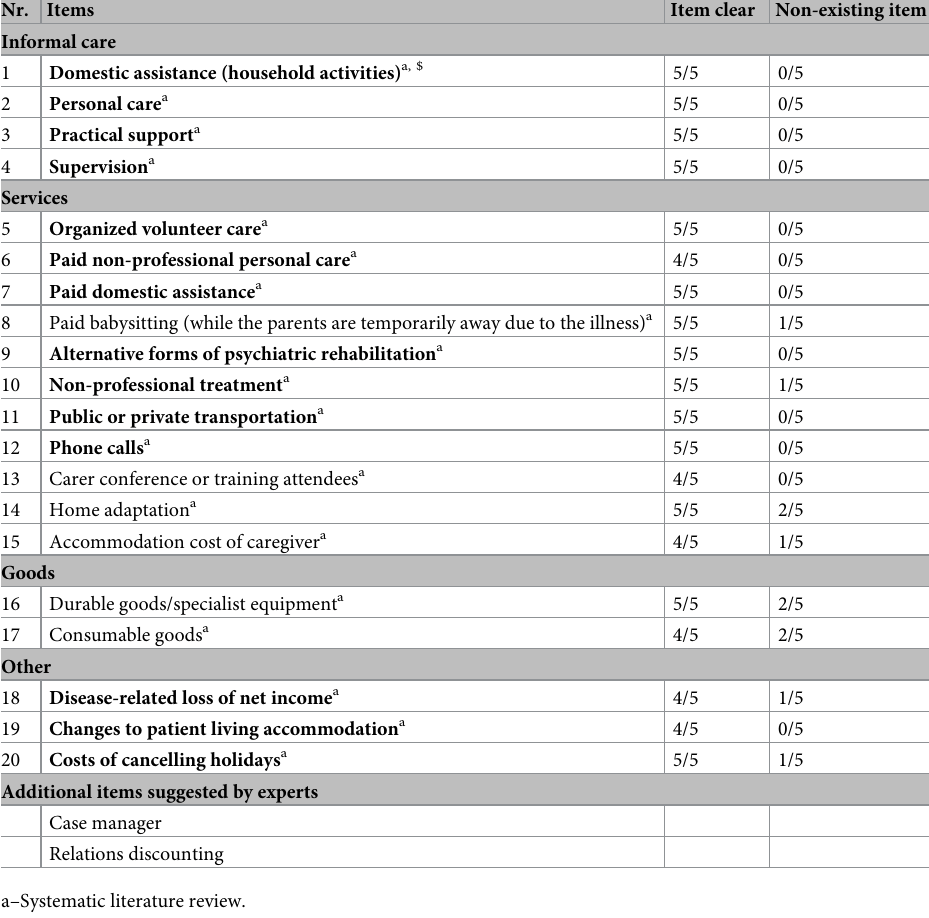
Table 5. Characteristics of items in the patient, family and informal care (PFI) sectors list, Austrian survey. Nr.